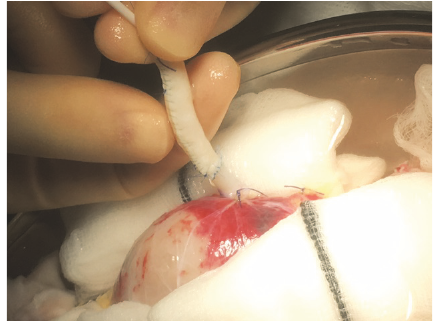
Figure 4: Completed E-E anastomosis between tubulised aortic patch and polar renal